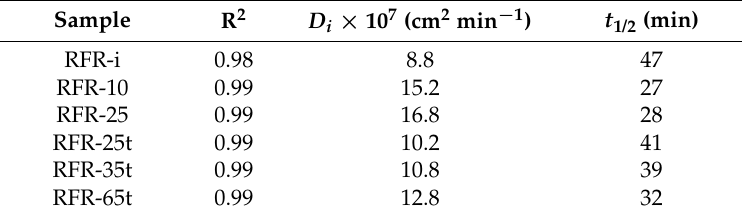
Figure 2. Kinetic curves of Cs-137 sorption in semi-logarithmic coordinates; ( a )—samples obtained